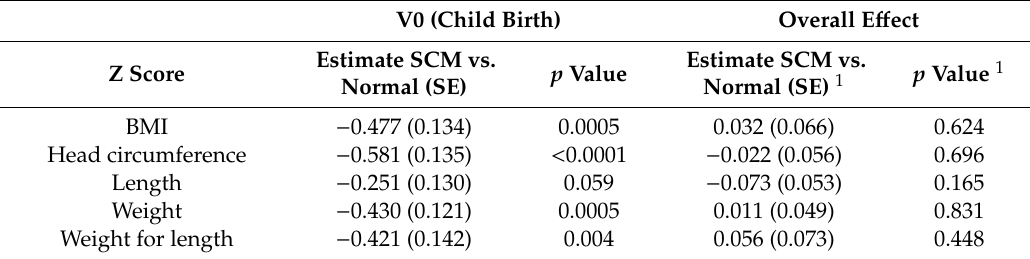
Table 5. Growth parameters of infants of SCM and normal